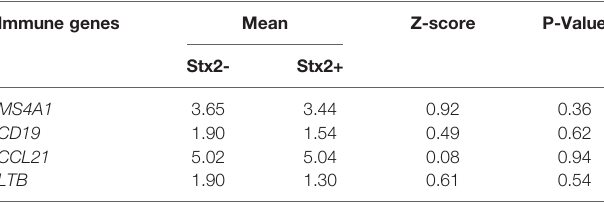
TABLE 5 | Expression differences for four host genes between Stx2+ and Stx2- samples using non-parametric Mann-Whitney U test.